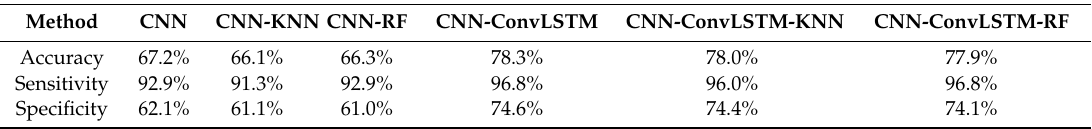
samples that were collected in the heavily furnished